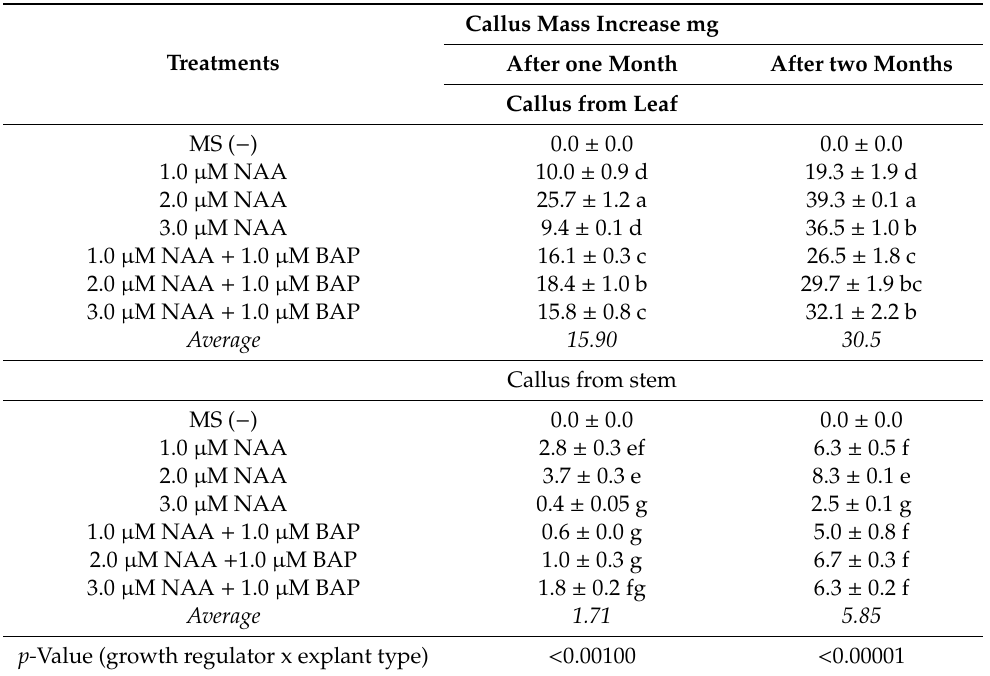
Table 2. E ff ect of growth regulators on callus-mass increase from stem and leaf explants. Mean value ± standard error, n = 3. Callus Mass Increase mg Treatments After one Month After two Months Callus from Leaf MS ( − ) 0.0 ±